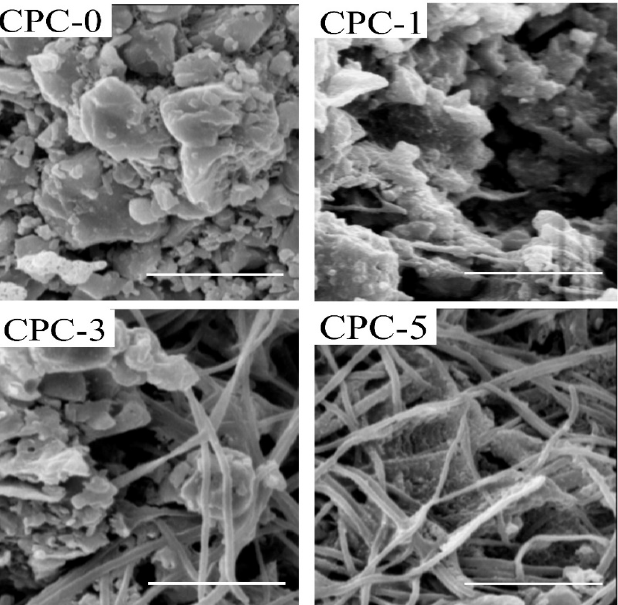
Figure 2. SEM images of cross-sectional surfaces of CPC composites. CPC appeared to be bonded onto the fiber surfaces. The electrospun SF/k-CG nanofibers were mixed well within the CPC paste. The scale bar is 10